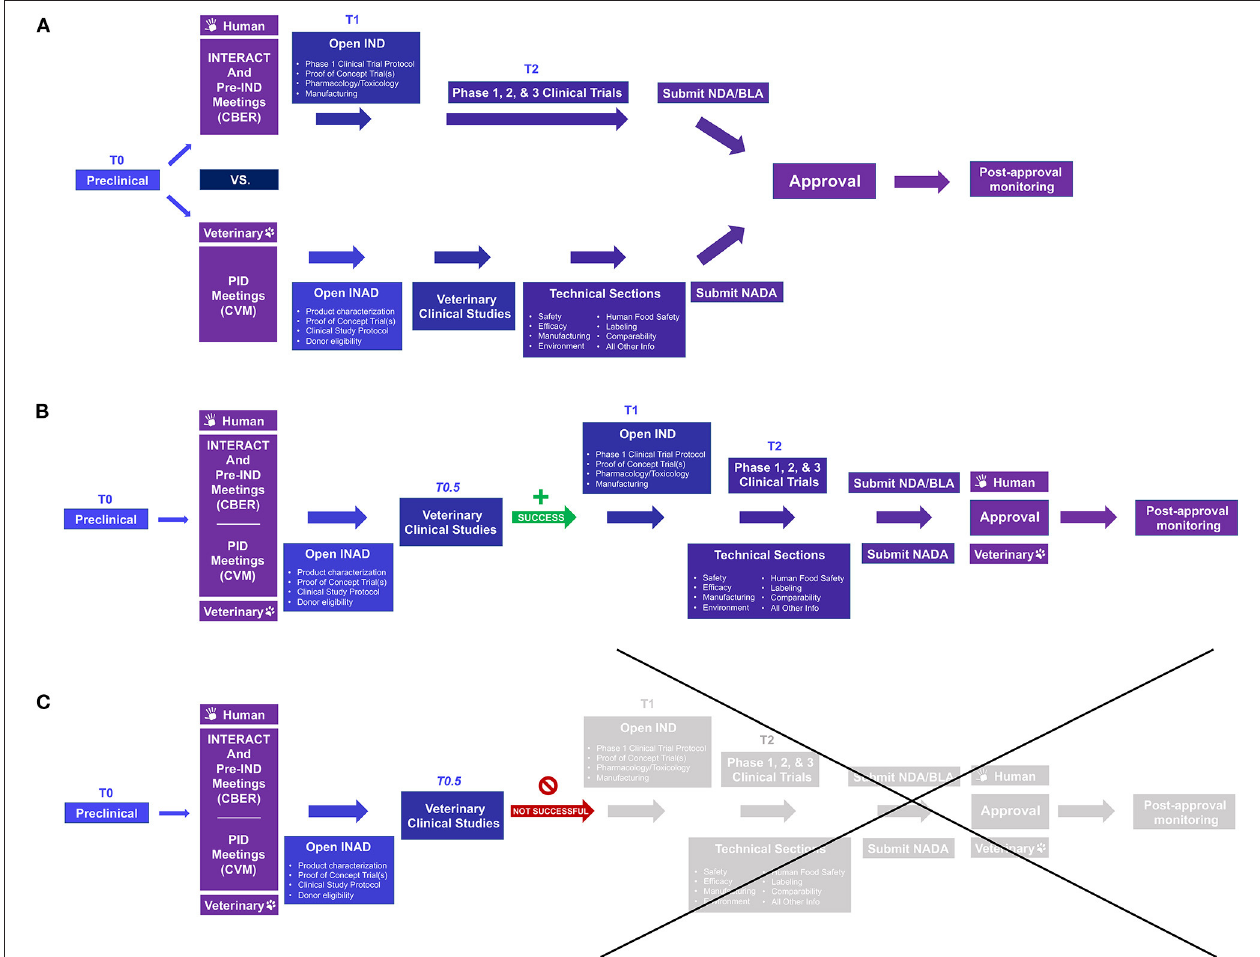
FIGURE 2 | Comparison of the US FDA approval process for human and veterinary cell-based products and opportunities to use data from naturally occurring models for dual species product approval. (A) Prior to conducting clinical investigations, an Investigational New Drug (IND) or Investigational New Animal Drug (INAD) application is filed with FDA Center for Biologics Evaluation and Research (CBER) or Center for Veterinary Medicine (CVM), respectively. For efficiency, INitial Targeted Engagement for Regulatory Advice on CBER producTs (INTERACT) and pre-IND meetings on the human side and Pre-Investigation Development (PID) meetings under the Veterinary Innovation Program (VIP) may be requested; for those wishing to pursue ‘dual species product approval’, i.e., using animal data for regulatory approval for both the veterinary and human product, it may be helpful to meet with both Centers early in the process. For veterinary drugs, clinical studies are not broken into phase 1, 2, and 3 studies as in human medicine. (B,C) Including appropriate naturally occurring/spontaneous animal models in the human drug investigation process (T0.5) can better inform whether proceeding to human clinical studies is worthwhile and, with planning, can not only save time and money but may lead to dual species product approval without significant extra investment. Once clinical studies have been completed, human drugs require additional submissions such as a Biologics License Application (BLA) or New Drug Application (NDA) for FDA review; veterinary products require submission of a New Animal Drug Application (NADA). Once a product receives FDA approval, post-approval monitoring must be performed to ensure continued safety and efficacy. For more information see: Lee MH, Au P, Hyde J, et al. “Translation of Regenerative Medicine Products into the Clinic in the United States: FDA Perspective.”